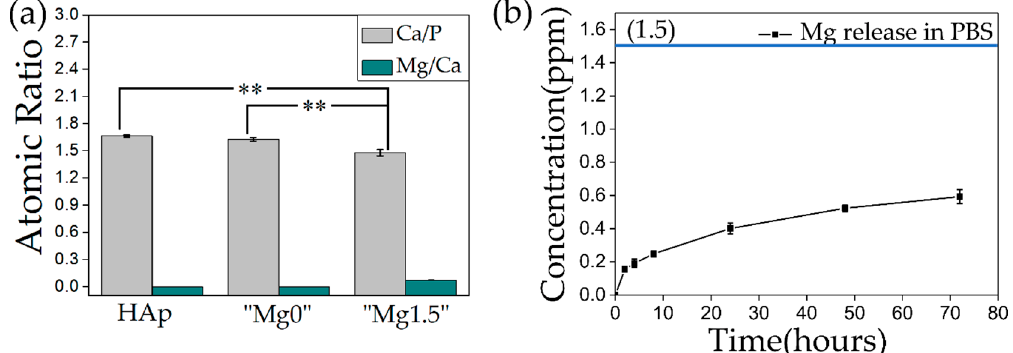
Figure 3. ( a ) Comparison of Ca/P and Mg/Ca atomic ratio of “Mg0” and “Mg1.5” particles with commercially available HAp particles. In ( a ), the symbol “**” indicates p < 0.01, and no symbol indicates p > 0.05 by one-way ANOVA followed by the Tukey’s tests. ( b ) release behavior of Mg ions from “Mg1.5” particles in the PBS. In ( b ), blue straight line shows 1.503 ppm which was assumed concentration if all the Mg contained in the “Mg1.5” particles had been released to the phosphorus buffered saline (PBS).